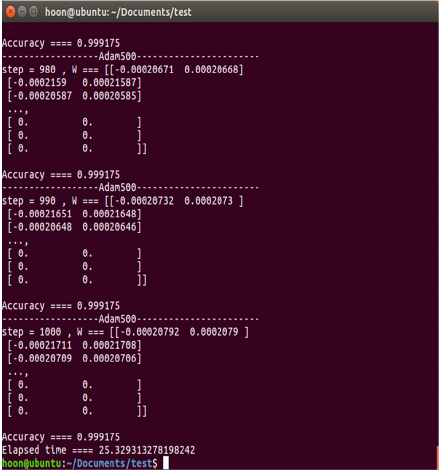
Figure 15. Scenario 1 experiment result: single learning (G-Descent ⇒ Adam).